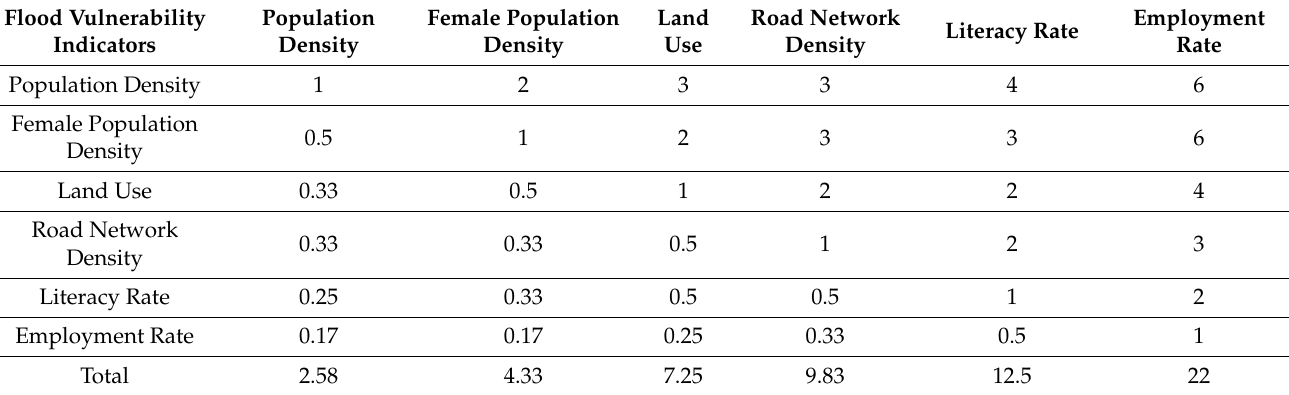
Table 4. Comparison matrix for flood vulnerability